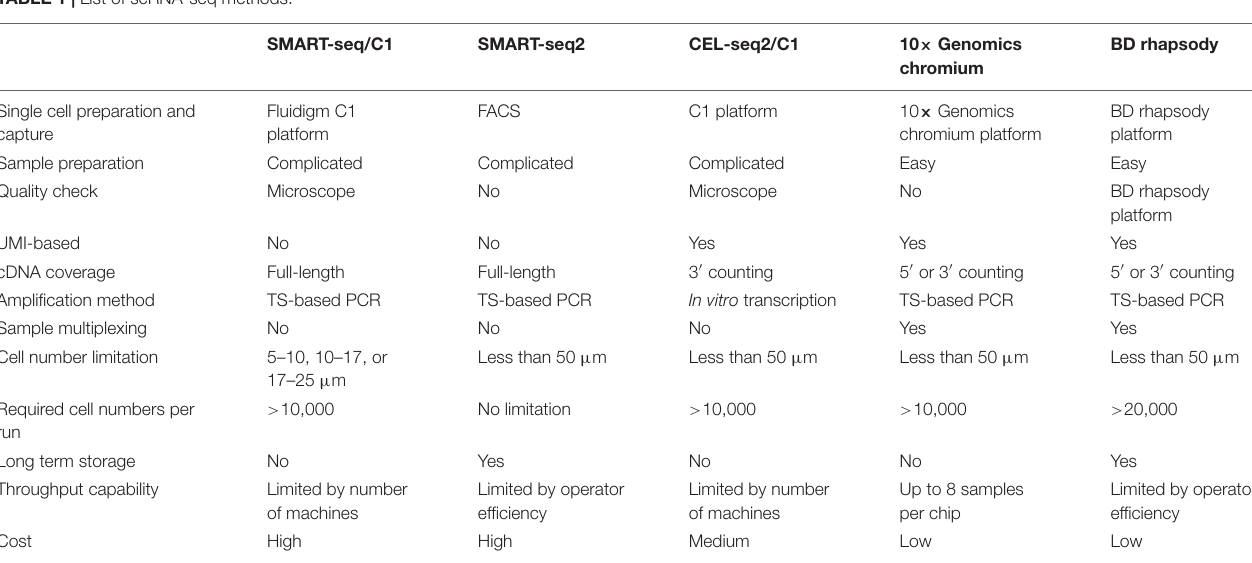
FIGURE 1 | Development of scRNA-seq and its applications in kidney immunology. LN, lupus nephritis; diabetic kidney disease; IgAN, IgA nephropathy; ANCA-GN anti-neutrophil cytoplasmic antibody-associated glomerulonephritis. TABLE 1 | List of scRNA-seq